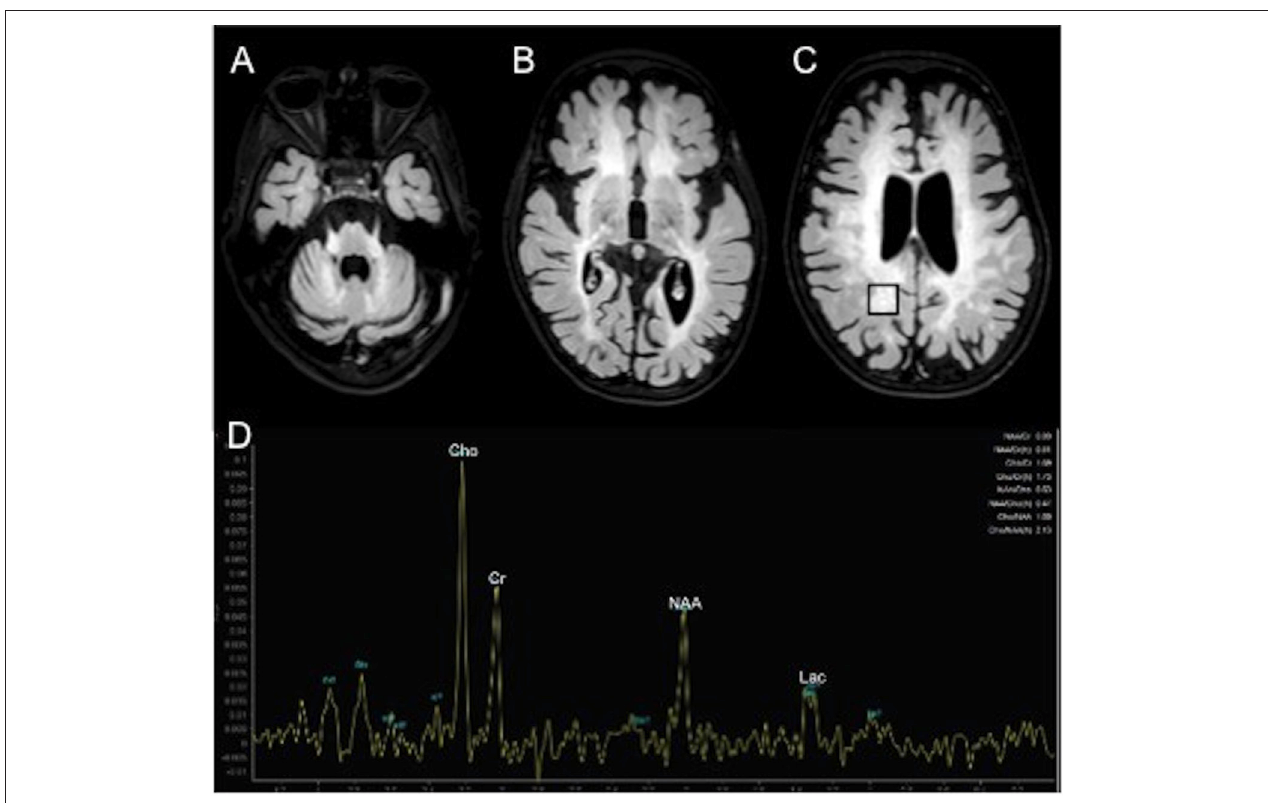
FIGURE 1 | Contrast enhanced brain MRI (A–D) . Axial T2 weighted FLAIR images show extensive areas of increased signal symmetrically involving the middle cerebellar peduncles and cerebellar peridentate white matter (A) and the cerebral white matter (B,C) . 1 H MR spectroscopy in the affected right parietal white matter (black box in C ) shows increased peaks of choline (Cho) and lactate (Lac) and decreased peak of N-acetyl-aspartate